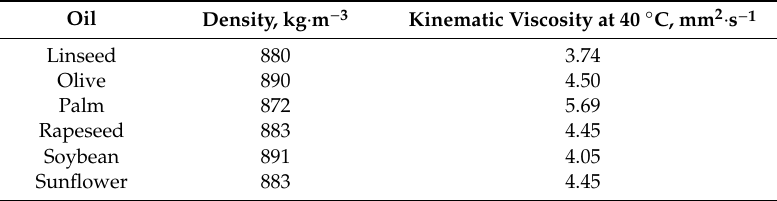
Table 7. Selected properties of the vegetable oils used.